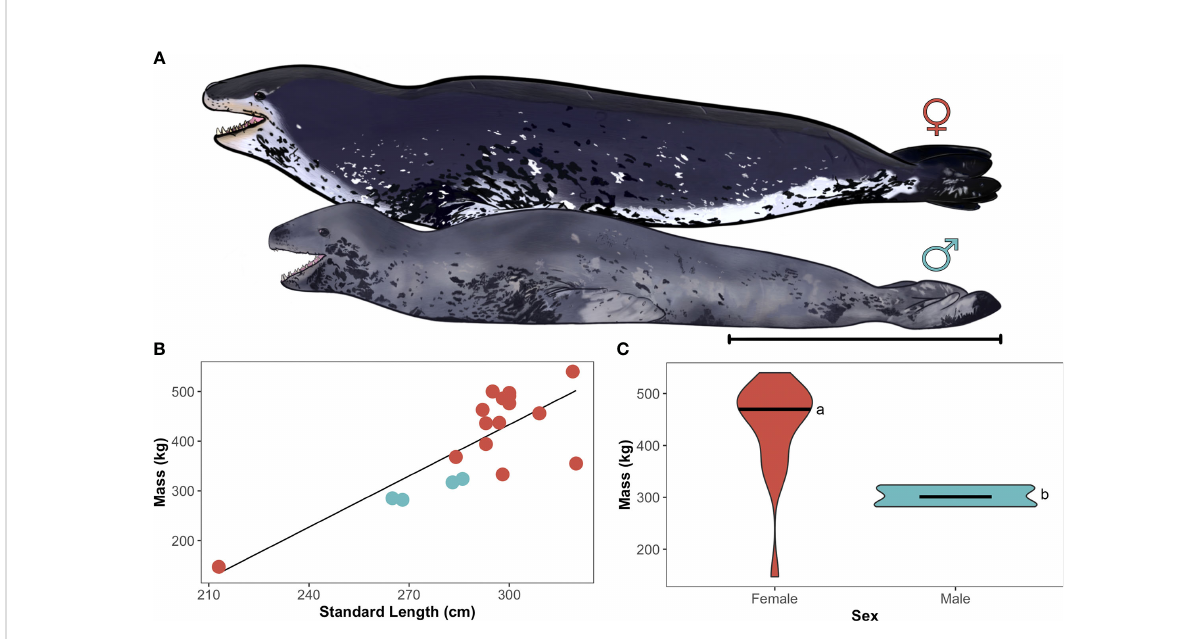
FIGURE 2 Female-biased sexual size dimorphism in adult leopard seals. (A) Illustration of scaled body morphometric differences between adult female (top) and male (bottom) leopard seals. Art by Aaron Kirkpatrick. Scale bar represents 1 m. (B) Linear regression of standard length (cm) and mass (kg) for adult leopard seals (females: red-orange, males: gray-blue; y=-600+3.4x, R 2 = 0.80, p<0.001). Each point represents an individual seal. (C) Violin plot comparing sex-speci fi c differences in body mass (kg), where females are signi fi cantly larger than males (a, b; t Horizontal bars represent the 25 th , 50 th (median), and 75 th